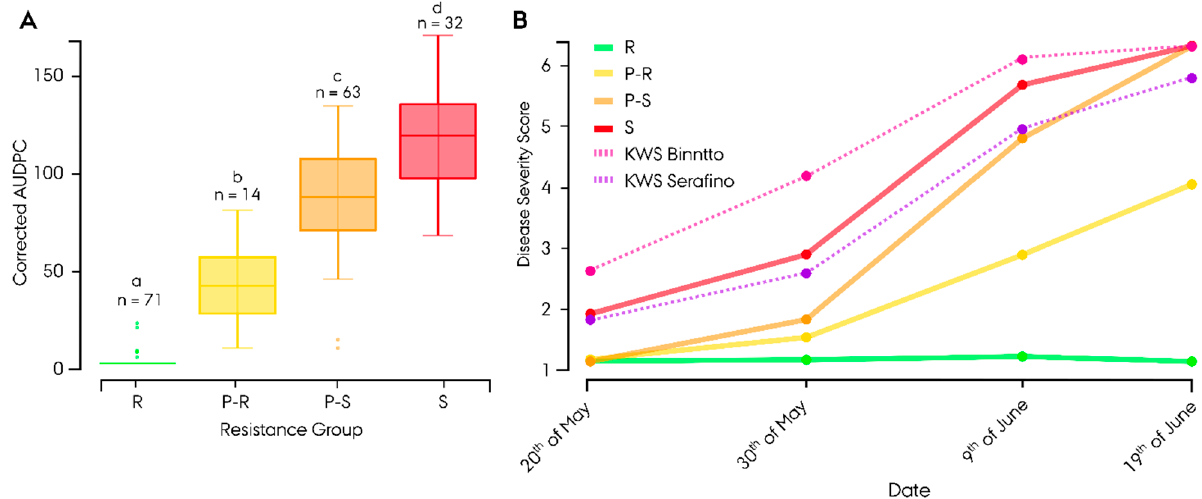
Figure 1. Leaf rust disease severity in 180 hybrid rye ( Secale cereale L.) breeding lines grouped according to resistance response at Gylling (Denmark) field trial in 2019. ( A ) Area under disease progress curve (AUDPC) boxplot with standard error of each assigned resistance response group— resistant (‘R’), partially resistant (‘P-R’), partially susceptible (‘P-S’) and susceptible (‘S’) groups—with different letters indicating significant differences ( p < 0.05). ( B ) Mean disease progression curve of each group during the growing season, including resistant control hybrid cv. KWS Binntto and susceptible control hybrid cv. KWS Serafino.